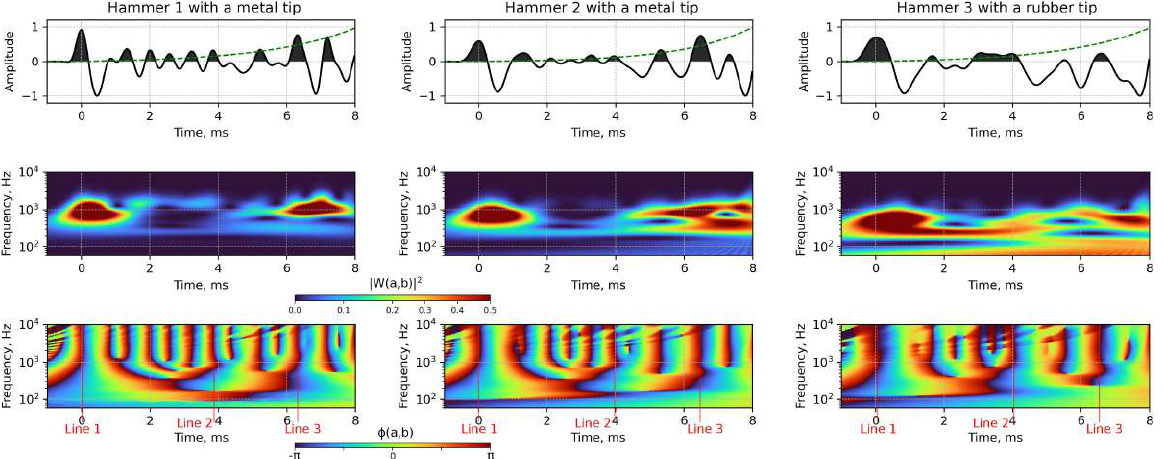
Figure 8. CCWT analysis of the field low strain tests of a driven precast pile of the unknown depth. The data was collected with a set of 3 hammers of different weights and tip materials. 1st row—the recorded signals, 2nd row—the distributions of energy of the wavelet transform coefficients, 3rd row—the distributions of phase angles of the wavelet coefficients. Lines 1, 2, and 3 delineate the phase shift